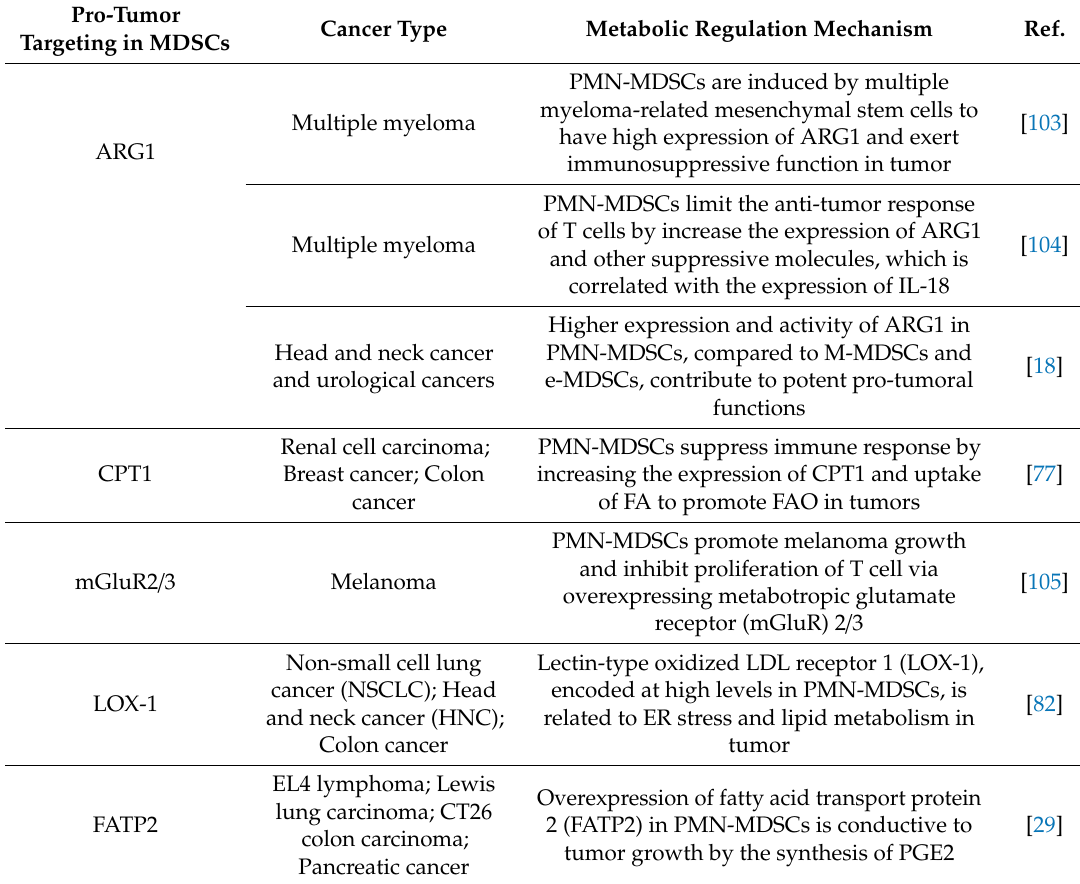
Table 3. PMN-MDSCs in